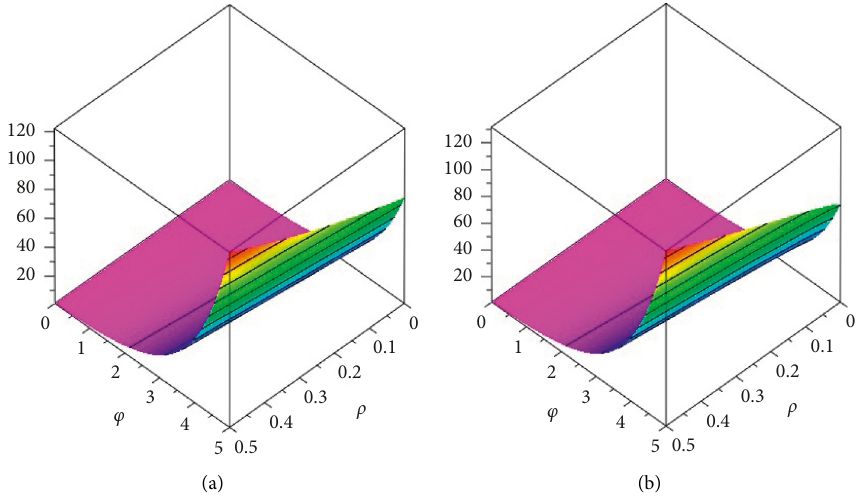
Figure 5: (a) The exact and approximate solution at δ � 1 and (b) second fractional order at δ � 0 . 8.